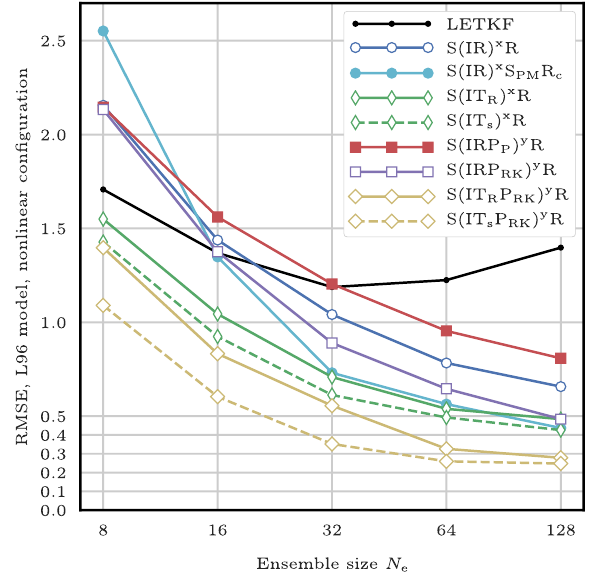
Figure C1. RMSE as a function of the ensemble size N e for the LETKF and the main LPFs, with the L96 model in the strongly non- linear configuration. Note that the ultimate increase of the RMSE of the LETKF with the ensemble size could have been avoided by us- ing random rotations in ensemble